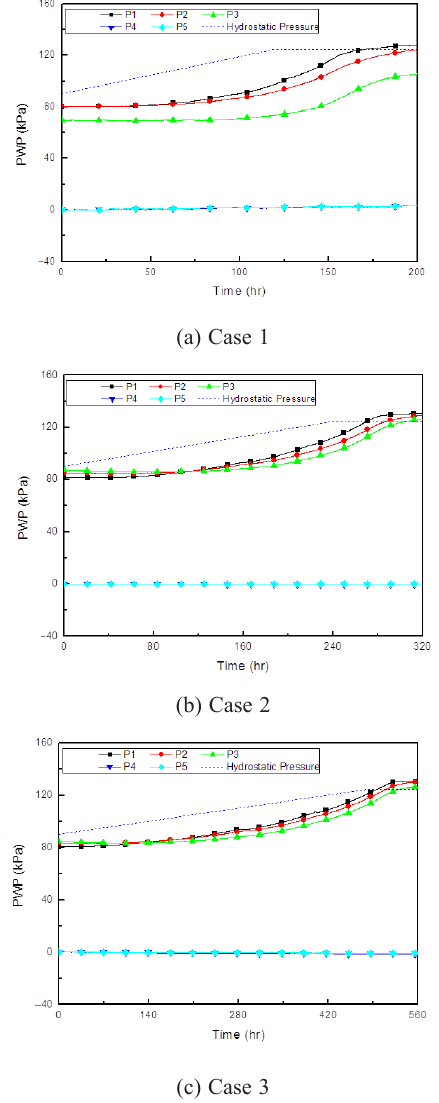
Fig. 5. Time histories of pore water pressure during water- level-raising process (after 62.5 hours) It can be observed that the pore water pressures in- crease nonlinearly with a linear water level rise in all cases. This increase is most likely observed because of the increase in the degree of saturation of the levee due to the seepage flow. In addition, smaller pore water pres - sures can be observed at points that are further away from the levee surface. In Case 1, the final pore water pressure at P3 is lower than the hydrostatic pressure. This finding means that the pore water near the pore water pressure transducer does not connect to the pore water at the top of the seepage area. This result suggests that the seepage area inside the levee is not fully saturated but instead is partly saturated, and pore air is trapped with the seepage water. It is also observed that the pore water pressure levels at P4 and P5 are almost zero because of limited outflow toward the rear side of the levee due to the low permeability of the core.